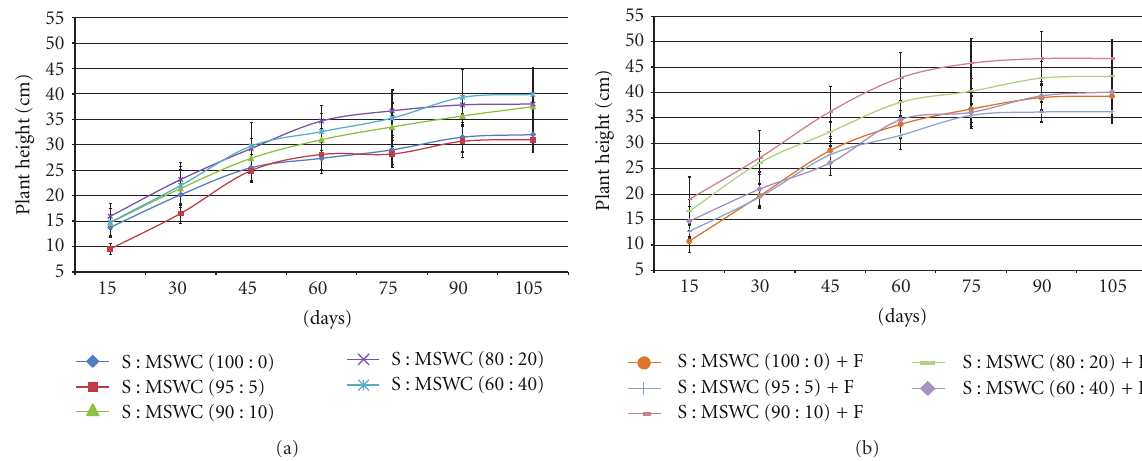
Figure 1: E ff ects of municipal solid waste compost (MSWC) into soil (S) without (a) or with (b) fertigation (F) on plant height of greenhouse pepper crop. Values represent mean ( ± SE) of measurements made on six plants per treatment.